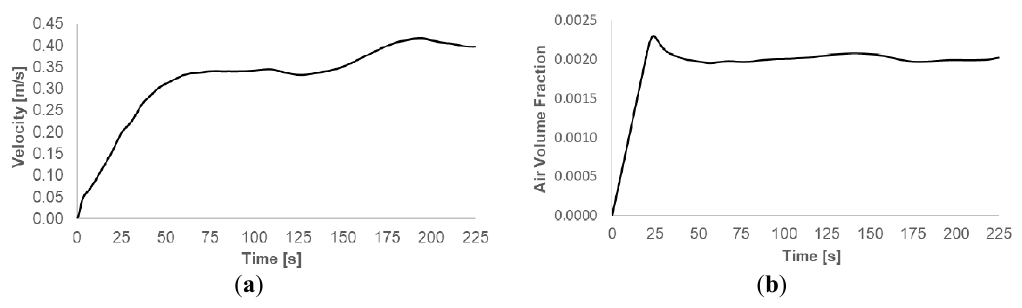
Figure 8. Water velocity plot ( a ) and air holdup plot ( b ).